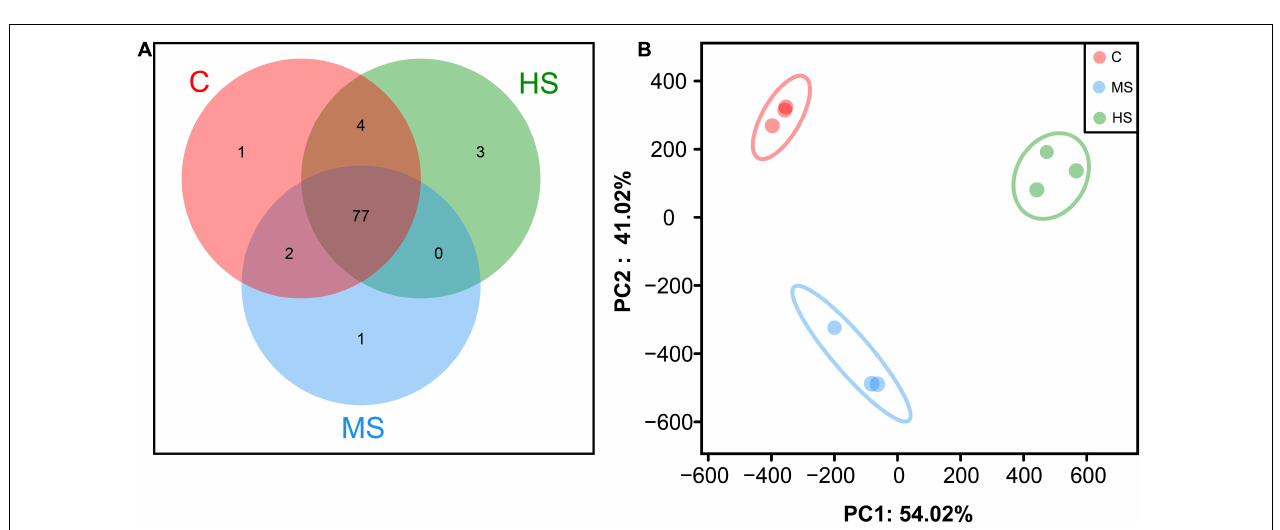
FIGURE 3 | Histological changes in the skin of Siberian sturgeon after exposure to the heat stresses. (A–C) indicates hematoxylin and eosin (H&E) staining, (D–F) represents Periodic Acid-Schiff (PAS) staining. (A,E) 20 ◦ C group, (B,F) 24 ◦ C group, (C,G) 28 ◦ C group, scale bar = 100 µ m. The exfoliated cells are shown by the white arrows, black arrows delegate mucus cells. (D) Skin health status (organ index) of sturgeon in different groups. (H) Mucus cell count between different groups, * p < 0.05 indicates a significant difference compared to the control group.